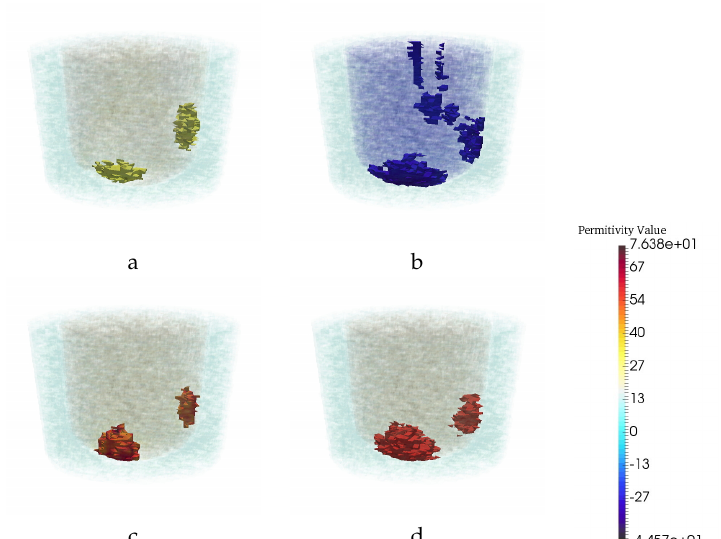
Figure 7. Reconstruction results for a particular example when the test images are CSI results for a breast phantom having a smaller fibroglandular region than those of the training set. The ( a ) real and ( b ) imaginary parts of the CSI reconstructions. ( c ) CNN reconstruction. ( d ) Ground truth.